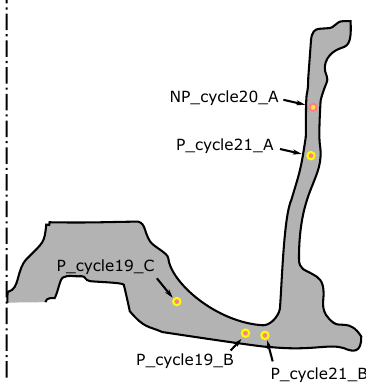
Figure 9. Cast-in TC